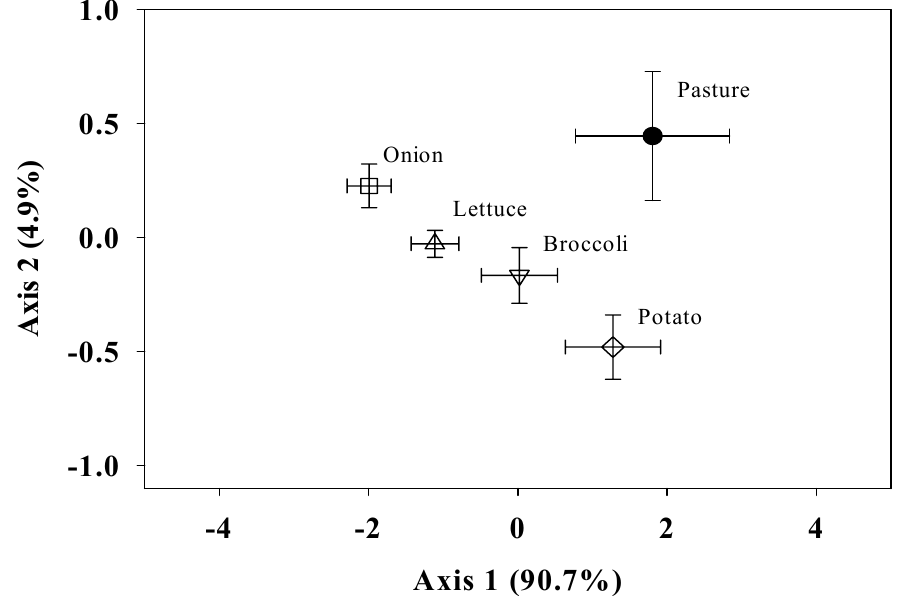
Figure 1. Principal component analysis (PCA) of soil microbial community composition according to 10 fatty acid methyl ester (FAME) indicators for fungal and bacterial populations under different rhizospheres in an organic production